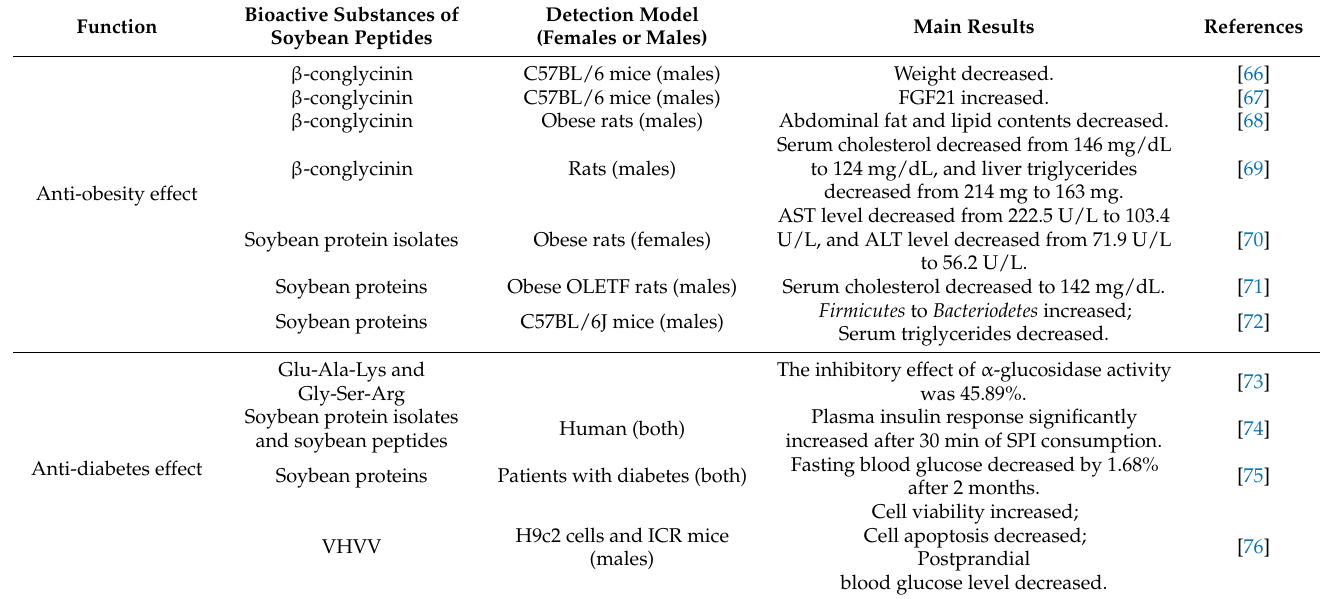
Table 1. The functions of soybean proteins and peptides in relation to chronic